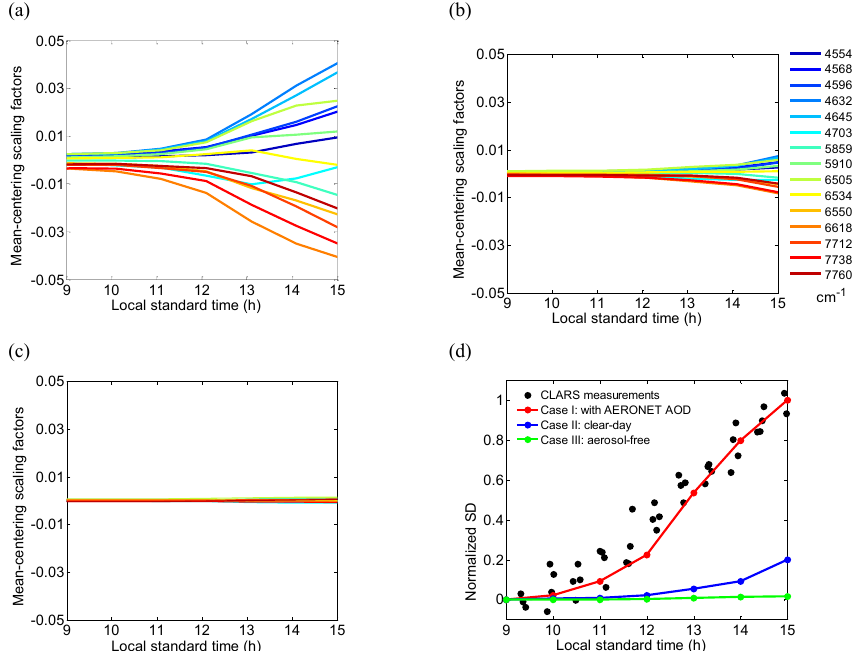
Figure 6. (a) Case I: scaling factors for H 2 O SCDs retrieved from the simulated synthetic spectral radiance of the 15 chosen bands using the 2S-ESS RT model with AOD data from AERONET-Caltech on 1 March 2013. The scaling factors are mean-centered by subtracting the mean to clearly show the variations in the retrievals; (b) Case II: same as (a) except that the AOD is fixed at the clear-day level, in which the lowest AOD in 2013 is used for all hours across the day; (c) Case III: same as (a) except that the AOD is set to be zero for all hours across the day; (d) Comparison between CLARS measurements and results from the three RT model experiments in (a) – (c) in terms of standard deviations, a measure of variations in H 2 O SCDs retrieved from the 15 chosen bands. The standard deviations are normalized to be between 0 and 1 for both measurements and simulations. The half-hourly mean of the CLARS data is calculated to obtain the maximum and minimum for the normalization. FTS by (1) using the 2S-ESS RT model to generate syn- (2) fitting the synthetic spectral data and retrieving H 2 O